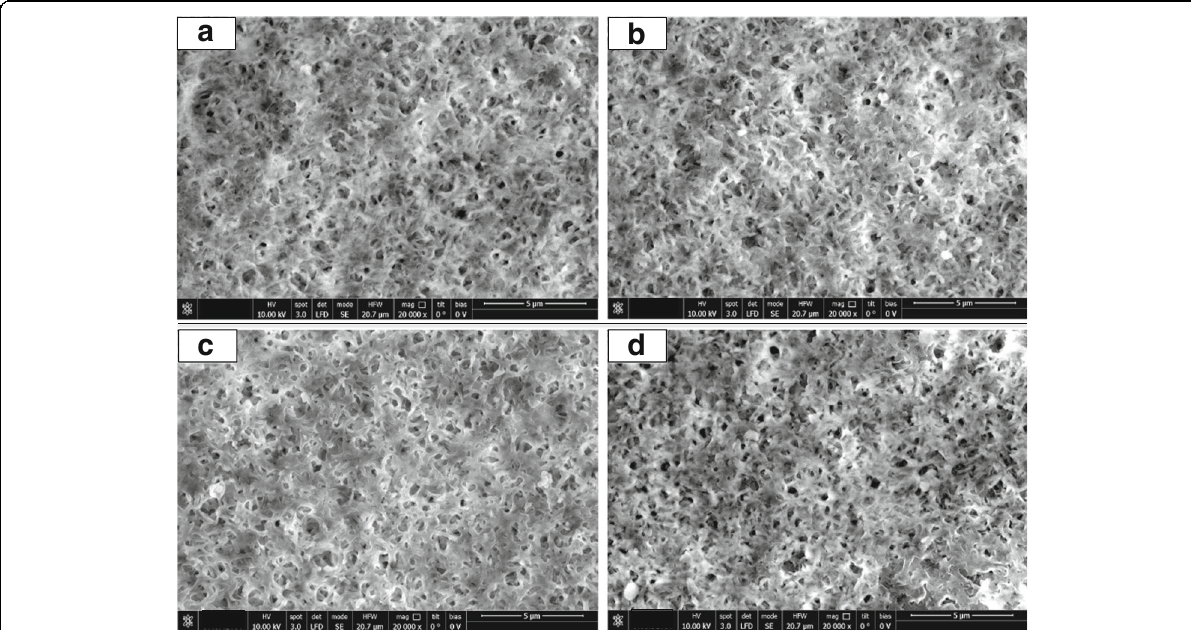
Fig. 5 SEM images at 20,000x of ( a ) top surface of untreated nylon membranes, ( b ) bottom surface of untreated nylon membranes, ( c ) top surface of CF4 plasma treated nylon membranes, ( d ) bottom surface of CF4 plasma treated nylon membranes